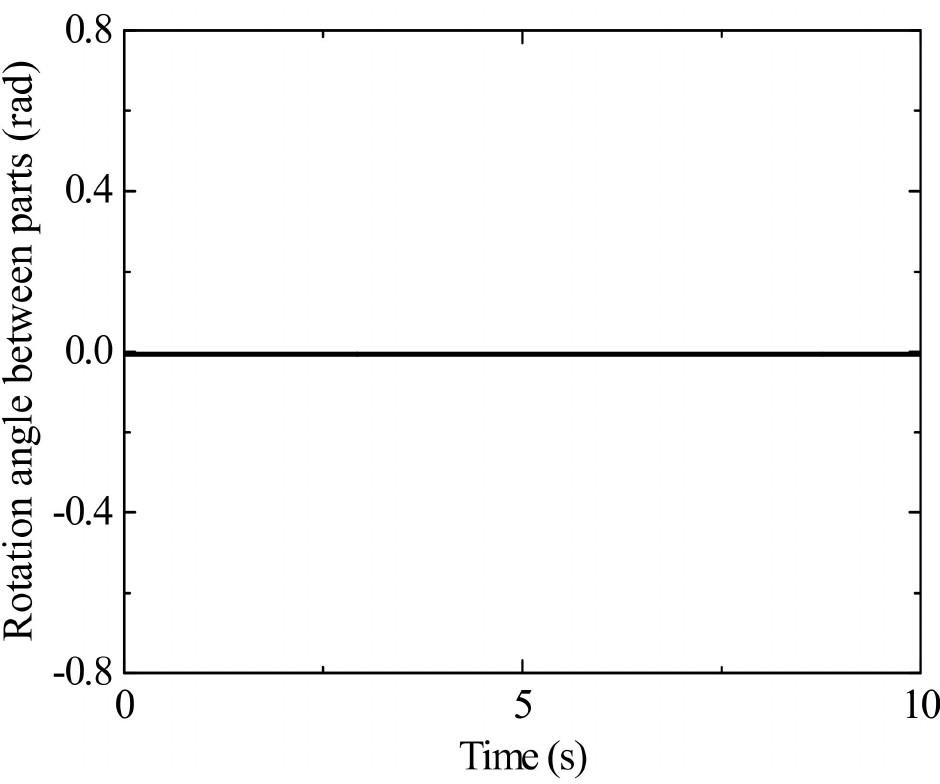
Figure 26. Relative attitude between the two modular components in the trajectory tracking stage.